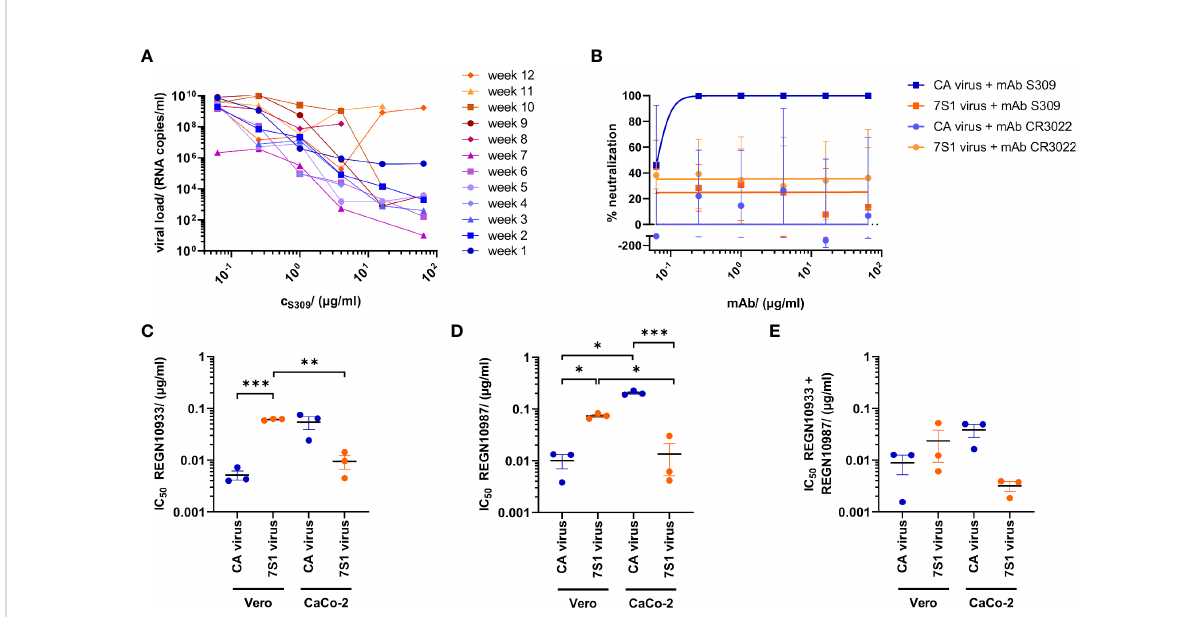
FIGURE 1 Selection and characterization of antibody-resistant SARS-CoV-2. (A) Cultivation of the SARS-CoV-2 input strain (GenBank accession no. ON715117) in Vero cells for 12 weeks, using increasing concentrations (c) of neutralizing monoclonal antibody (mAB) S309 or non-neutralizing mAB CR3022 (see Supplementary Figure 1). Data show mean viral loads in cell culture supernatants of each passage at 5d post infection, transferred weekly in duplicates to fresh cells containing fourfold increased antibody concentrations. A virus control without antibodies was included in each passage and continuously propagated during the entire selection period. (B) Neutralization of input strain (CA) and resistant (7S1) virus by increasing S309 and CR3022 concentrations. (C – E) Neutralizing activity (inhibitory concentration 50%, IC50) of (C) REGN10933, (D) REGN10987 and (E) a combination of both Regeneron antibodies on Vero and CaCo-2 cells. Viral loads were determined in cell culture supernatants using RT-qPCR 2d post infection and plotted as percent neutralization in a non-linear fi t. Data show mean and standard error of three independent experiments. Statistics is based on repeated measures (RM) one-way ANOVA, adjusted for multiple testing using Tukey ’ s correction. *p<0.05; **p<0.01;